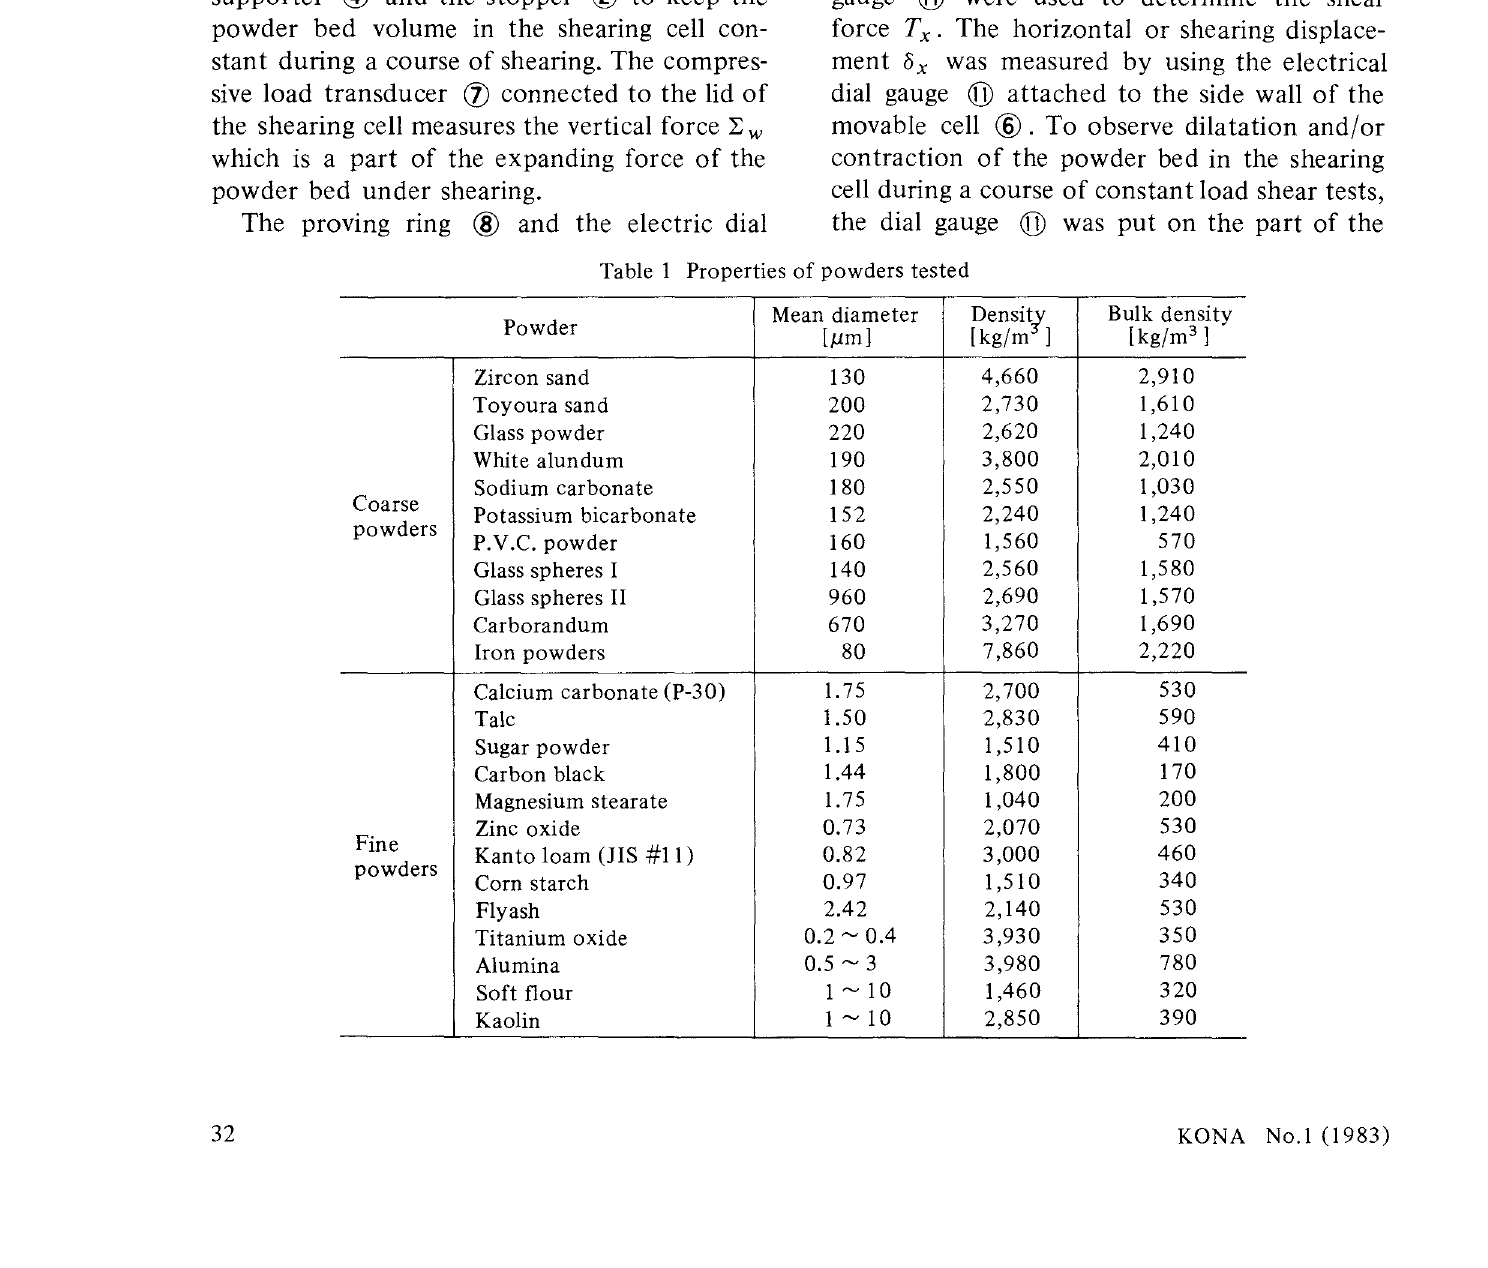
Fig. 5 Layout of pressure transducers in the vicinity of shearing